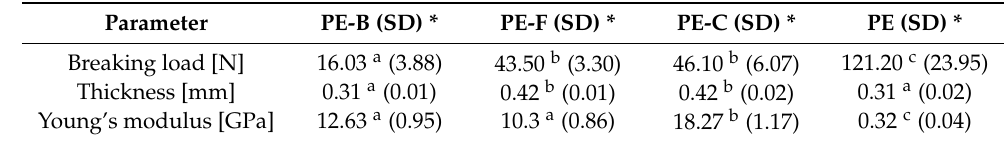
Table 1. Measurement of maximum breaking load, Young’s modulus and thickness of PE–pomace based